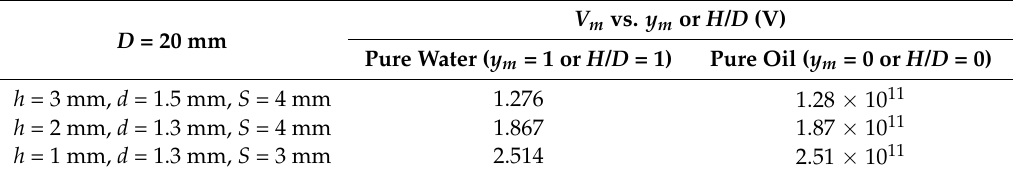
Table 2. The calculated response of the MCP with different structure parameters in the conditions of pure oil and pure